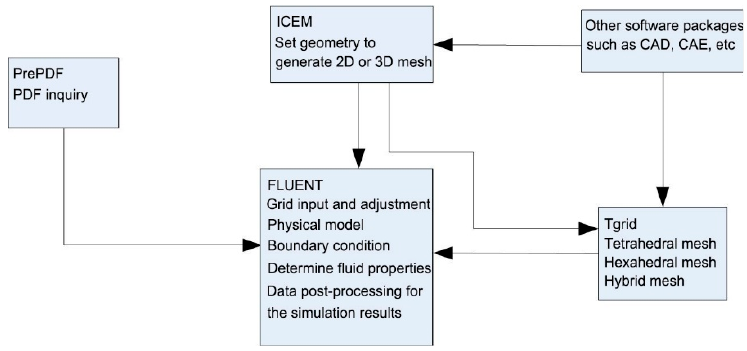
Figure 4. Procedure for the construction of the FLUENT model.